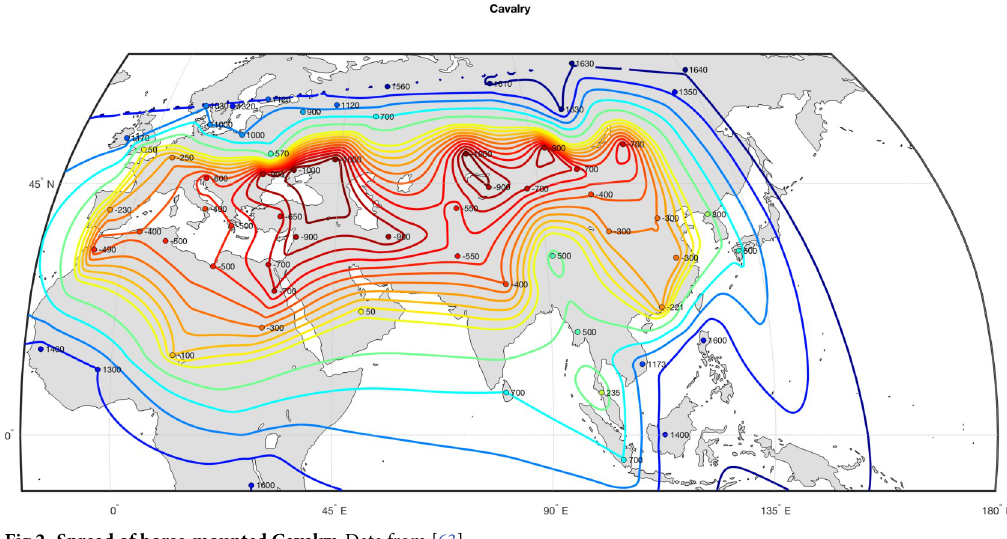
Fig 2. Spread of horse-mounted Cavalry. Data from